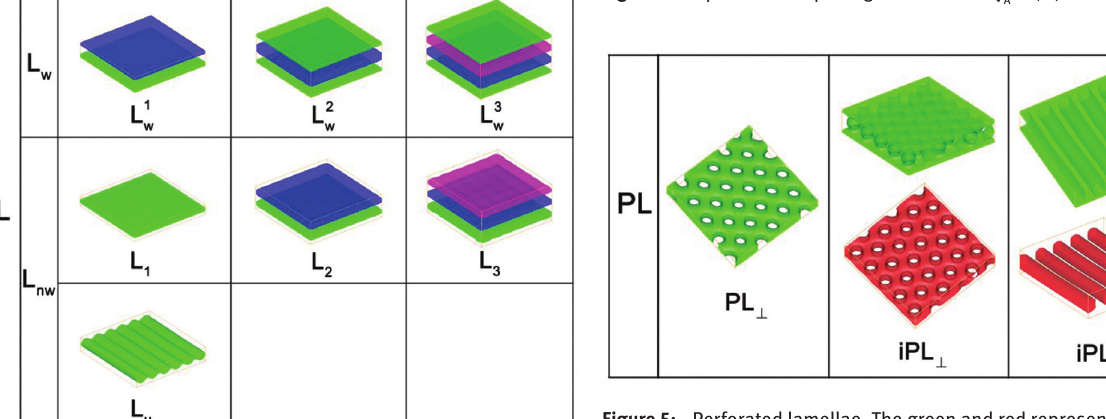
= 1/3) and block B A